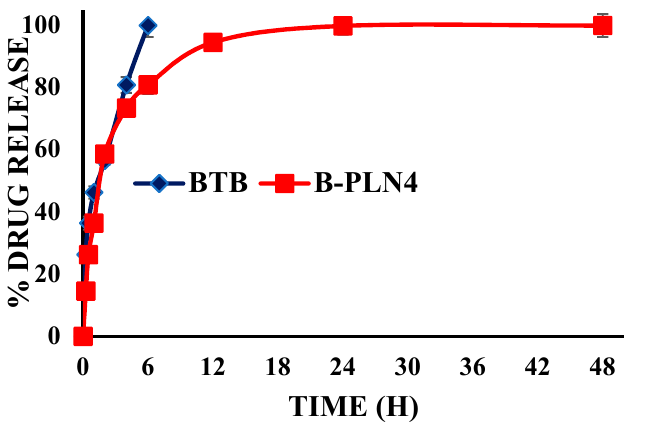
Figure 4. Comparative in vitro release profile of pure drug BTB and optimised B-PLN4 formulation.